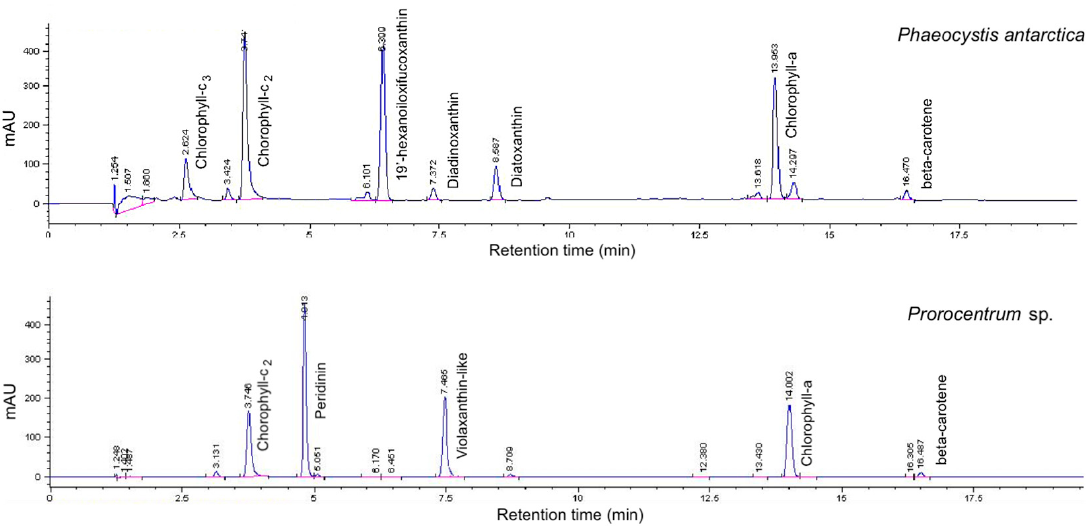
Figure 2. Chromatograms in absorbance (mAU) of the two species.